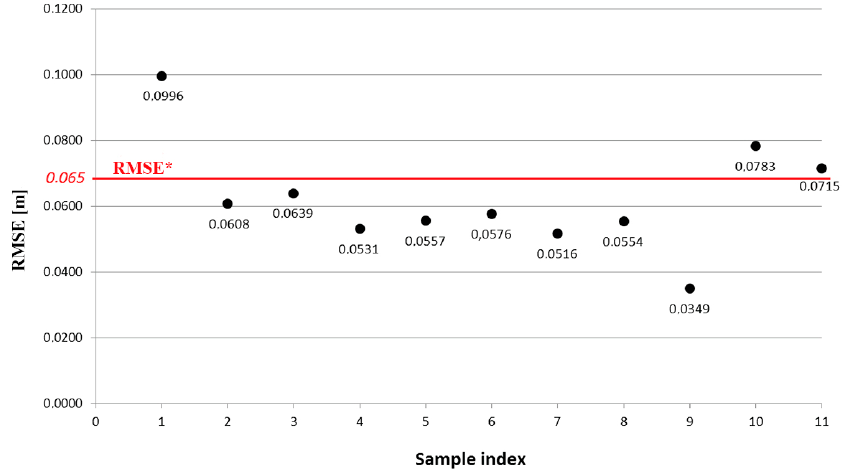
Figure 16. Graph of RMSE values obtained downstream of the registration process (Section 4.2.3) on P 0, n P a , n pairs of 3D point clouds.